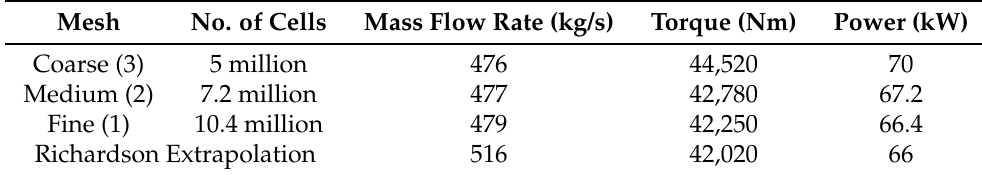
Figure 9. Variation in the power output with the turbine rotational speed for the first design. Table 6. Grid convergence study for first turbine at Ω = 15